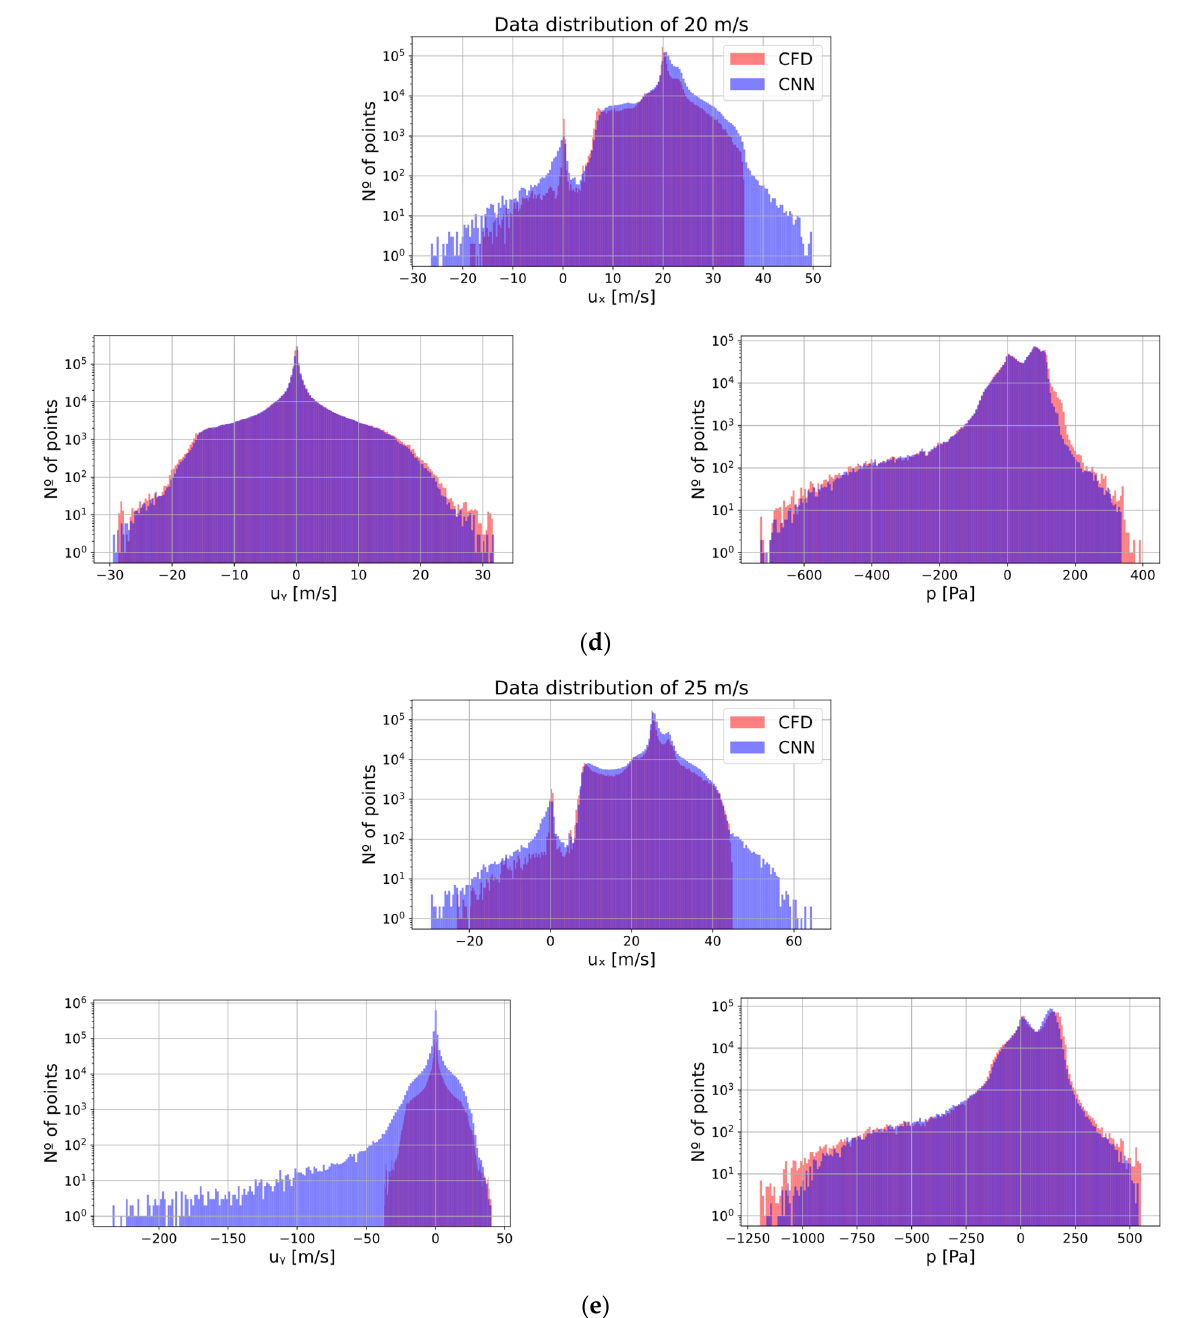
Figure 8. Data distribution of u x , u y and p for inlet velocities of ( a ) 5 m/s, ( b ) 10 m/s, ( c ) 15 m/s, ( d ) 20 m/s and ( e ) 25 m/s.